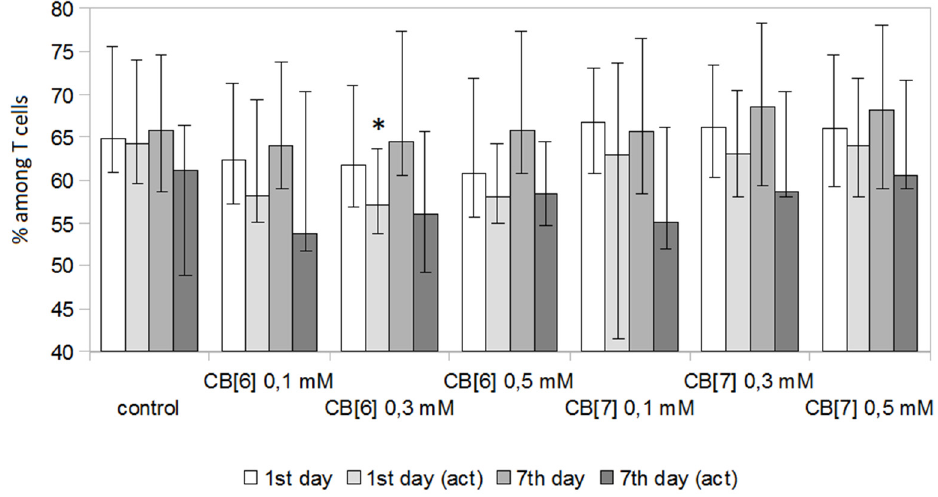
Figure 3. Percentage of CD3 + CD4 + T ‐ helper cells in PBMCs cultivated in the presence of CB[n] at various concentrations. Data are presented as the median with interquartile range. (* Indicates a significant difference ( p < 0.05) vs. the control. (act)—Culture of PBMCs activated with anti ‐ CD3 antibodies.